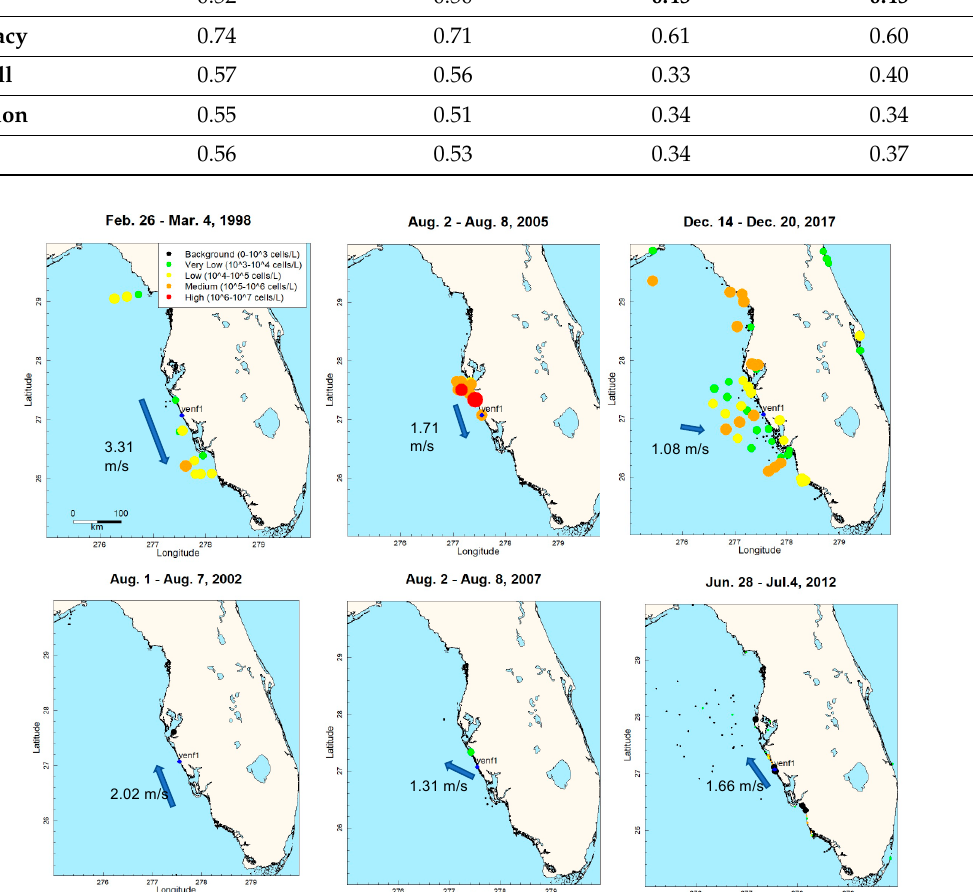
Figure 5. Examples of winds associated with blooms (top panels) and winds for periods without blooms (lower panels). Arrows denote wind direction.